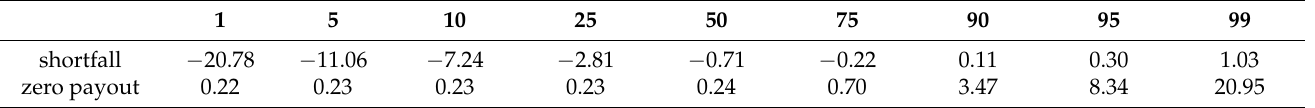
Table 7. Short fall and zero payout percentiles.